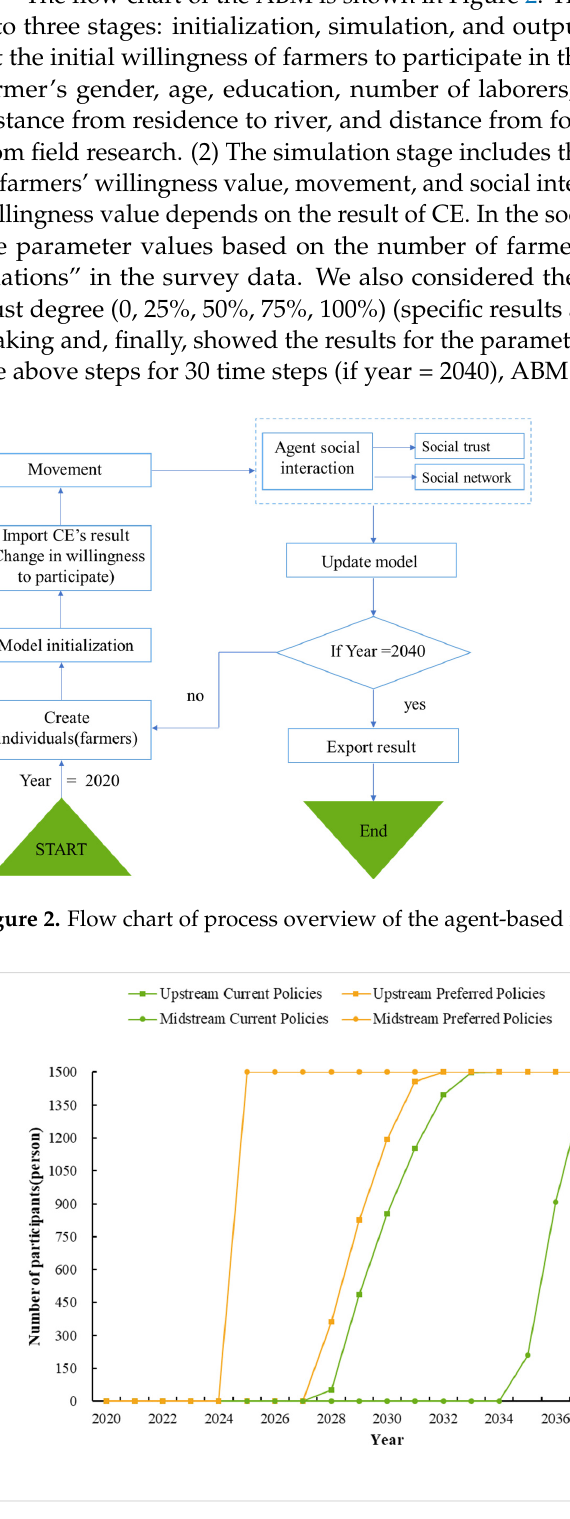
Figure 3. Number of participating farmers in the two policy scenarios.